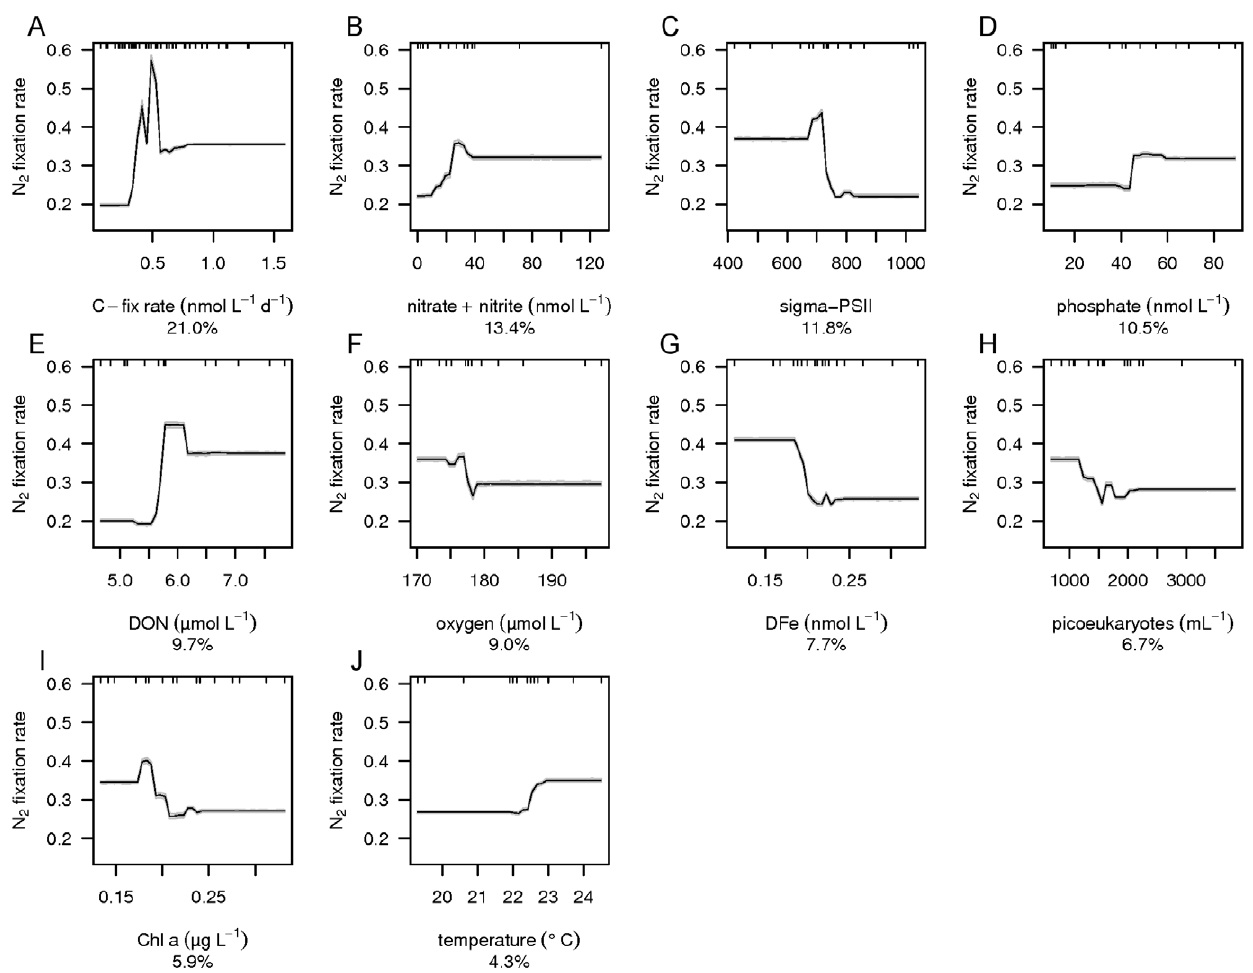
Figure 8. Mean partial dependence plots for the environmental variables describing the N 2 fixation rates. Mean partial dependence plots with 95% confidence intervals (light grey, based on bootstrapping of 30 BRT runs and indicating robustness of model performance) for the 10 environmental variables which explain the variation in N 2 fixation rates best. The environmental variables are A) C-fix rate, B) phosphate, C) nitrate + nitrite, D) sigma-PSII, E) DON, F) oxygen, G) DFe, H) picoeukaryotes, I) Chl a , and J) temperature. The y-axis is centered to have zero mean over the distribution of fitted N 2 fixation rates. A common scale is used for the x-axis. Rug plots at inside top of plots show the distribution of sites across that variable, in